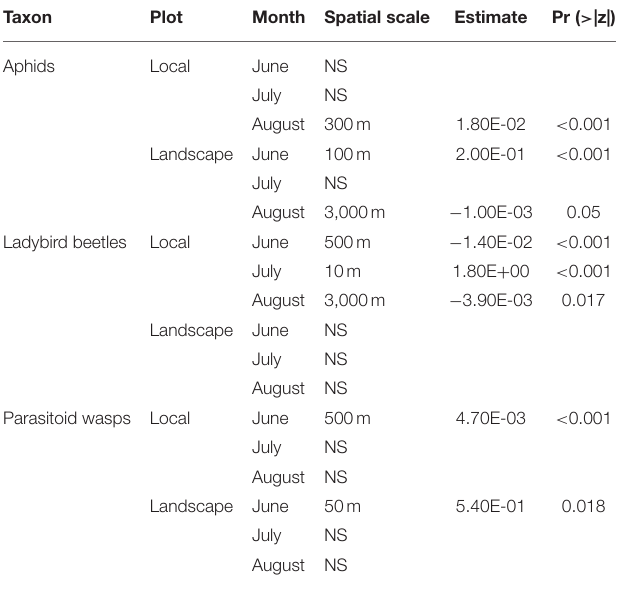
TABLE 1 | Summary of garden effects on arthropods. Taxon